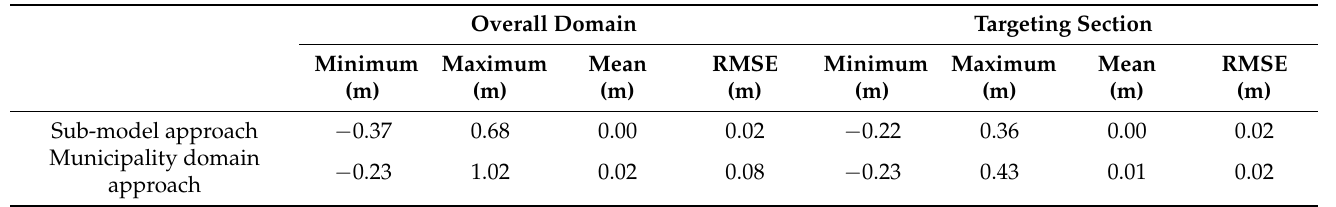
Table 2. Statistics of flood maximum depth difference for the sub-model approach vs. the municipality domain approach. Overall